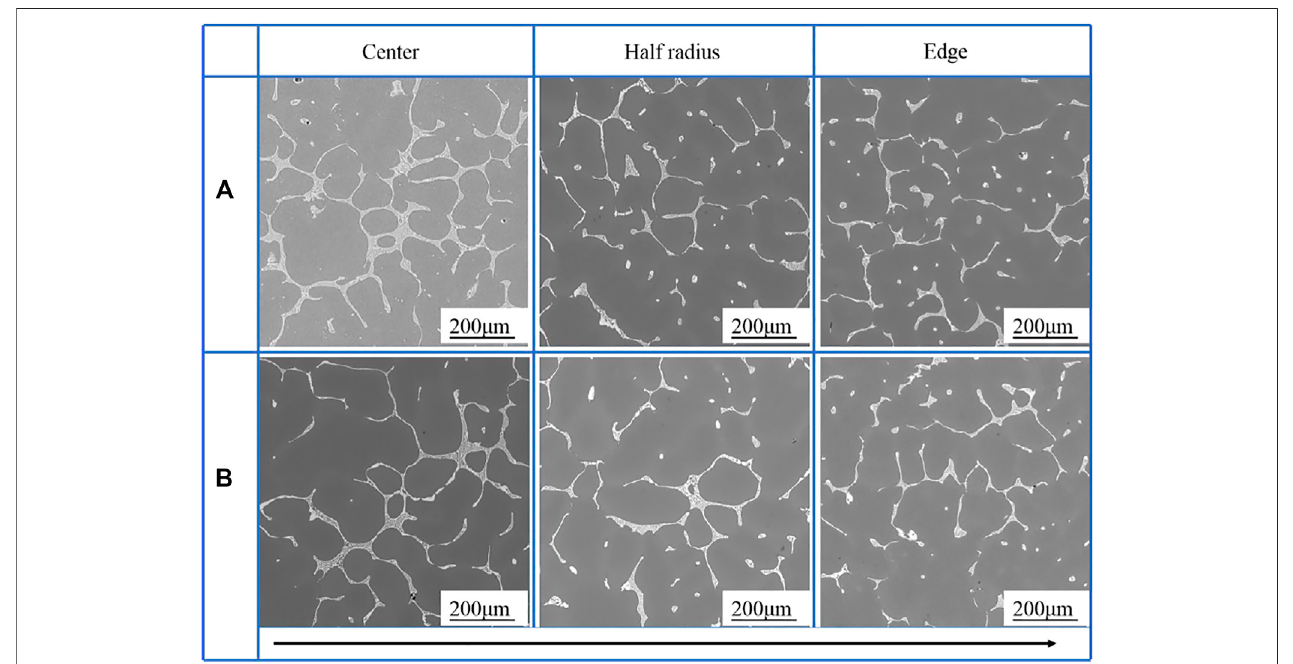
FIGURE 8 | The SEM images of the two ingots treated with (A) TSU and (B) DSU.